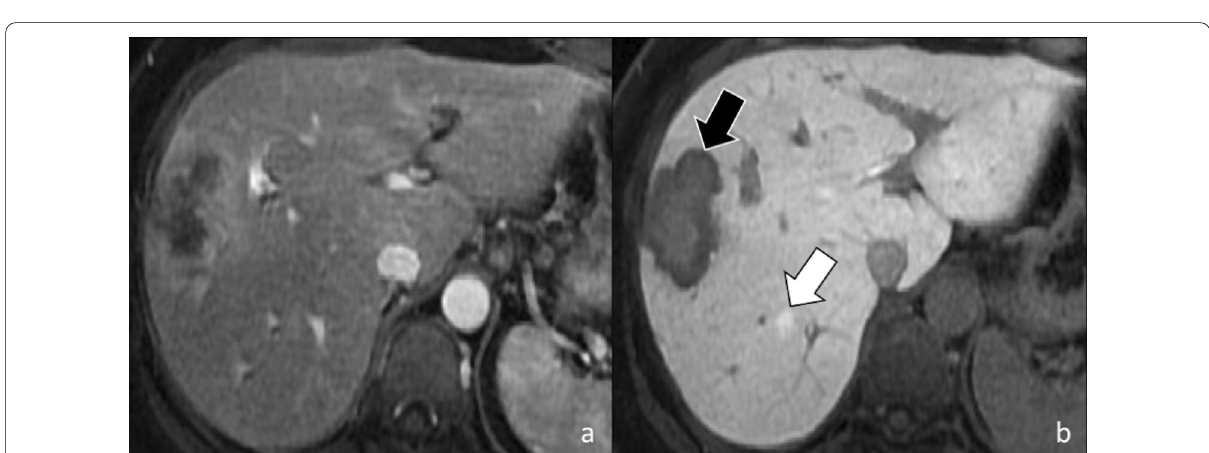
Fig. 16 44-year-old woman with breast cancer and liver metastasis treated with chemotherapy. Gadoxetate disodium-enhanced MRI shows a 7 mm regenerative nodule (white arrow) that is not visible in the arterial phase ( a ), and shows contrast retention in the hepatobiliary phase ( b ). In the same patient a liver metastasis (black arrow) shows peripheral rim enhancement in the hepatic arterial phase ( a ) and a target appearance in the hepatobiliary phase ( b ) with central hyperintensity due to contrast retention and a peripheral hypointense